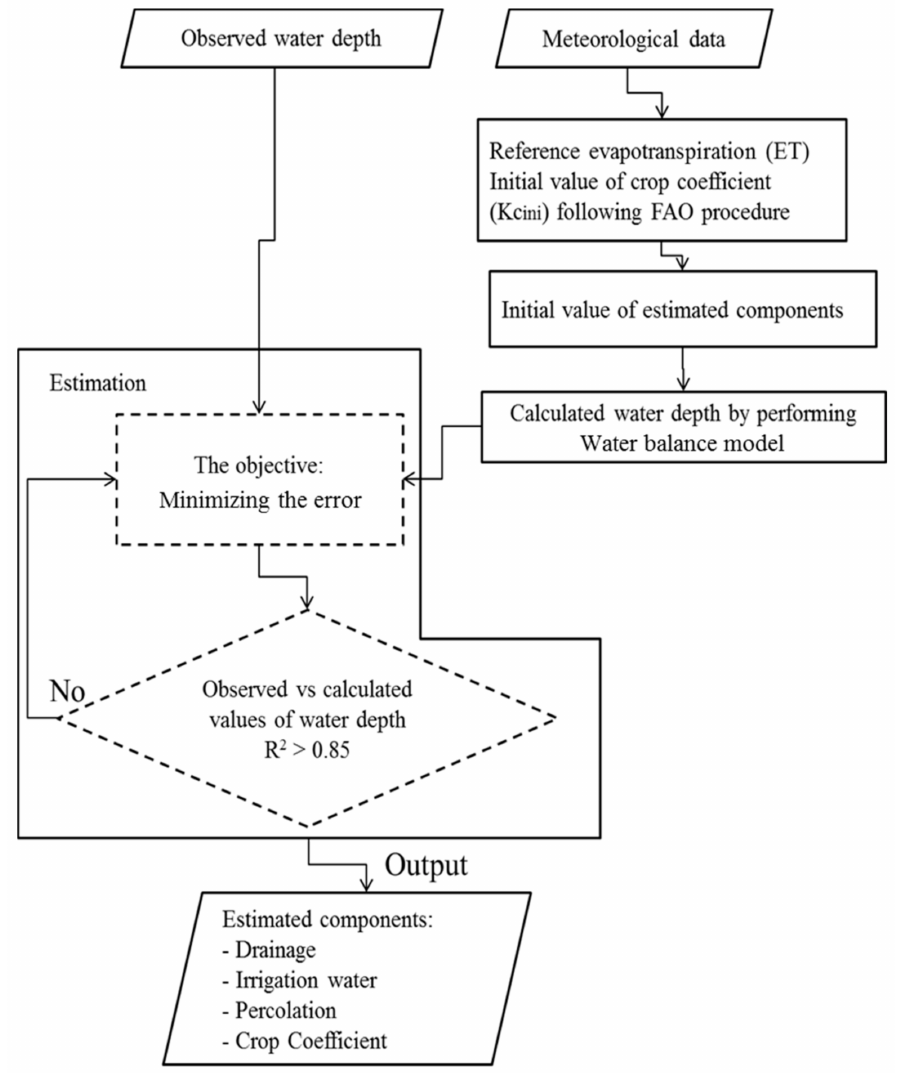
Figure 4. Schematic diagram for the estimation of non-measurable water balance